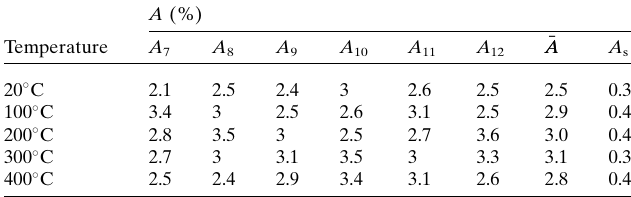
Table 6 Elongation of EBW joints.